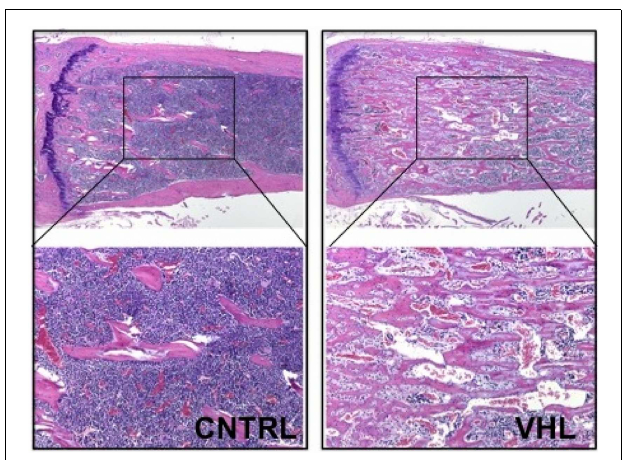
FIGURE 1 | Loss ofVHL in cells of the osteoblast lineage increases trabecular bone mass . H and E of histological sections of tibia isolated from 4-month-old control (CNTRL) and OSX-VHL mutant (VHL) mice; bottom panels are blows up of a and b, respectively. For details, seeText.